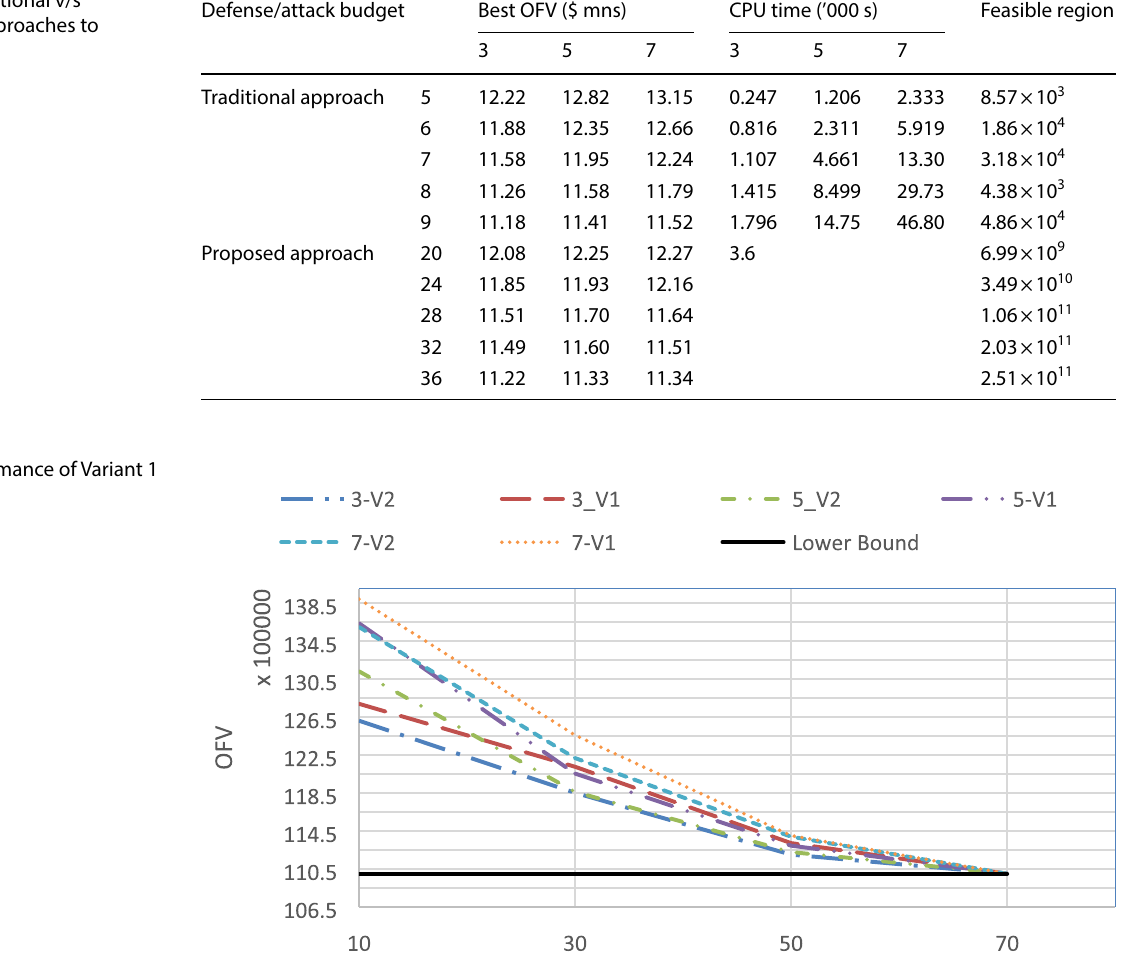
Table 3 Traditional v/s proposed approaches to fortification